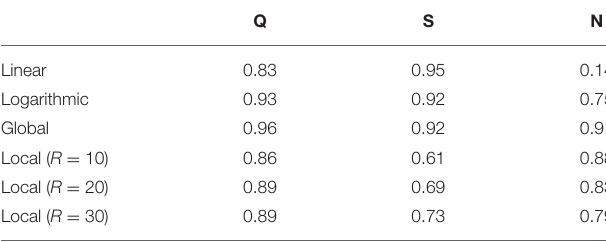
TABLE 1 | Median quality metrics for the “city” video.